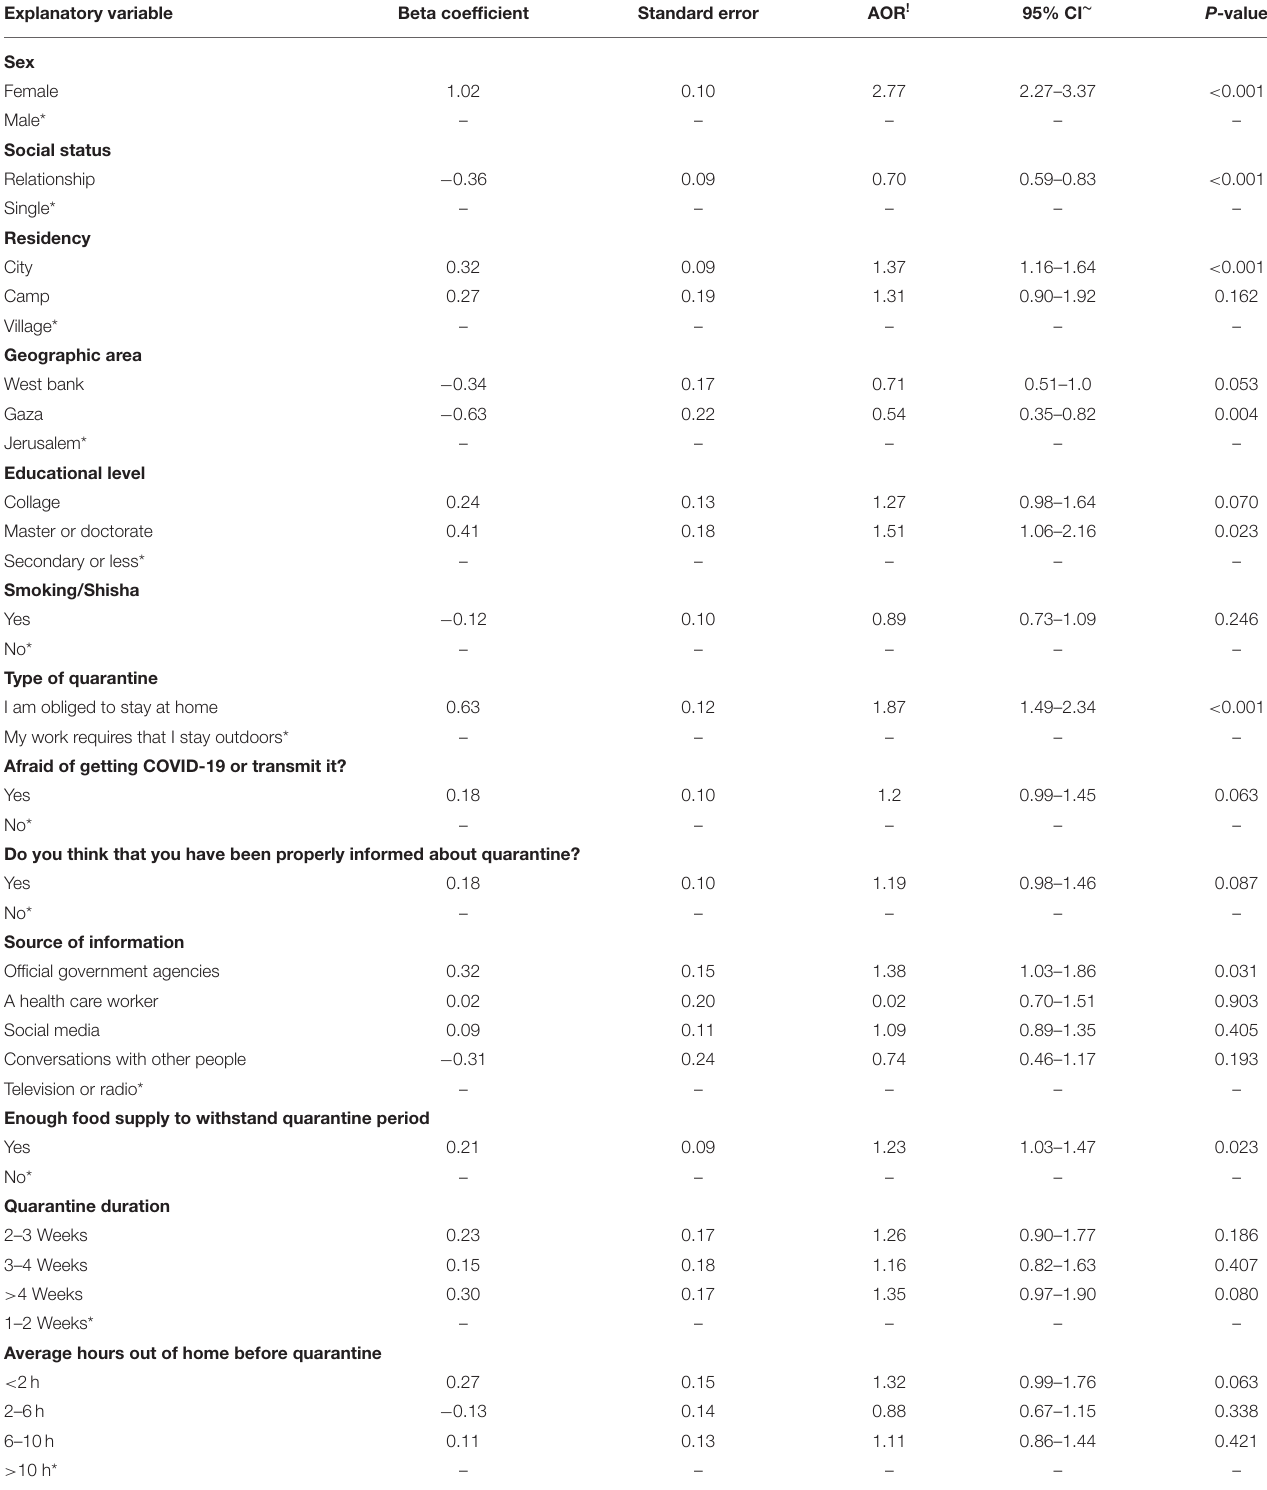
TABLE 3 | Multivariate logistic regression model for factors associated with staying home adherence ( N =